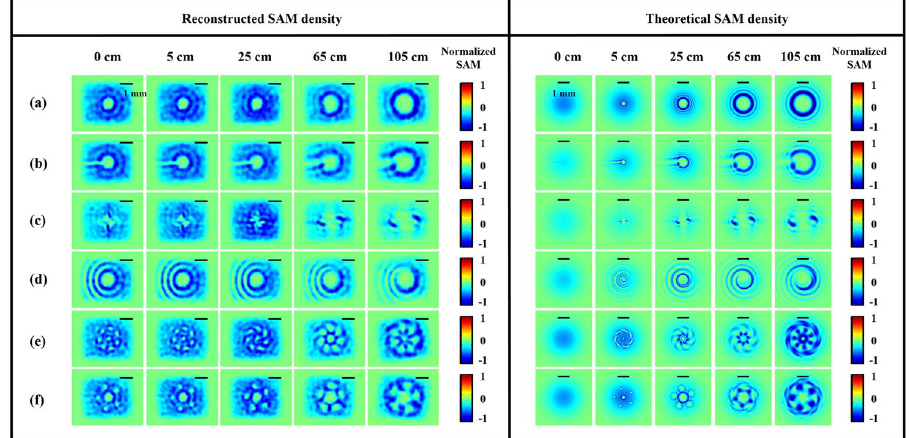
Figure 6. Spatial SAM density distributions of modulated beams on different cross sections. Left: DH reconstructed results; right: simulation results. Each case corresponds to that in Fig. 2. The color bar shows the normalized quantity of SAM densities in units of Ns / m 2 . The scale bar at the top in each figure is about 1 mm.